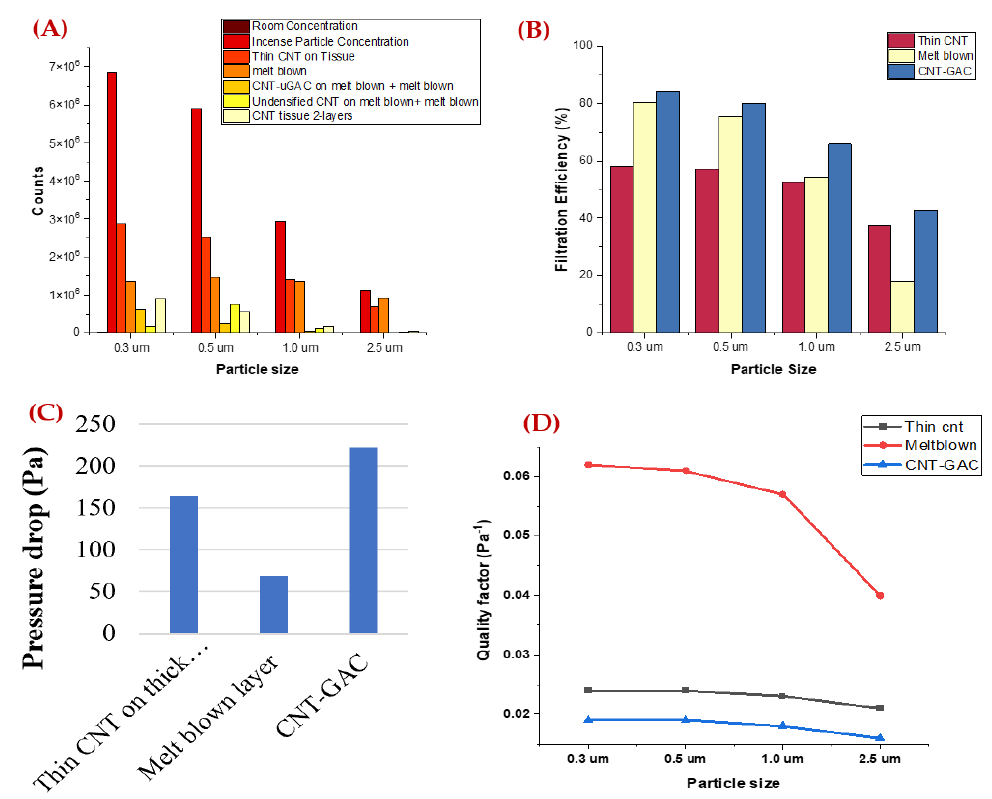
Figure 5. Single-layer filter performance ( A ) PM concentration, ( B ) Filtration Efficiency, and ( C ) Pressure drop of filters, and ( D ) Quality Factor.